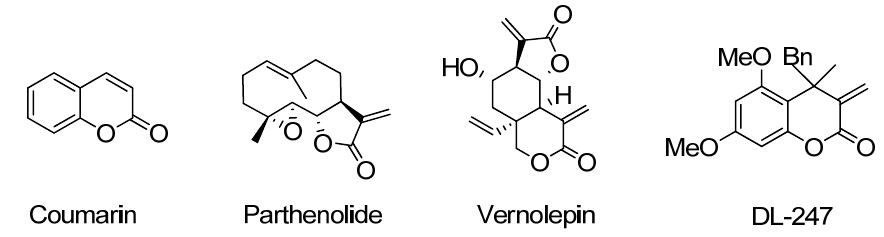
Structures of coumarin, parthenolide, vernolepin and a new hybrid DL-247 (4-benzyl-5,7-dimethoxy-4-methyl-3-methylidene-3,4-dihydro-2 H